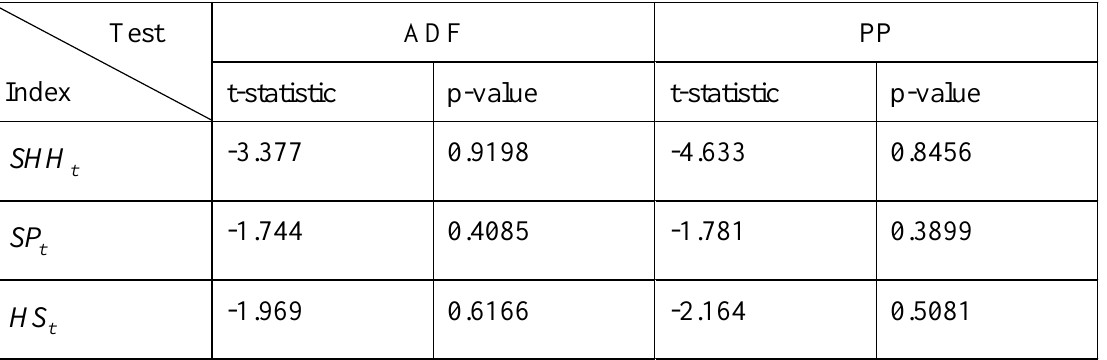
Table 2: Unit root tests for the index